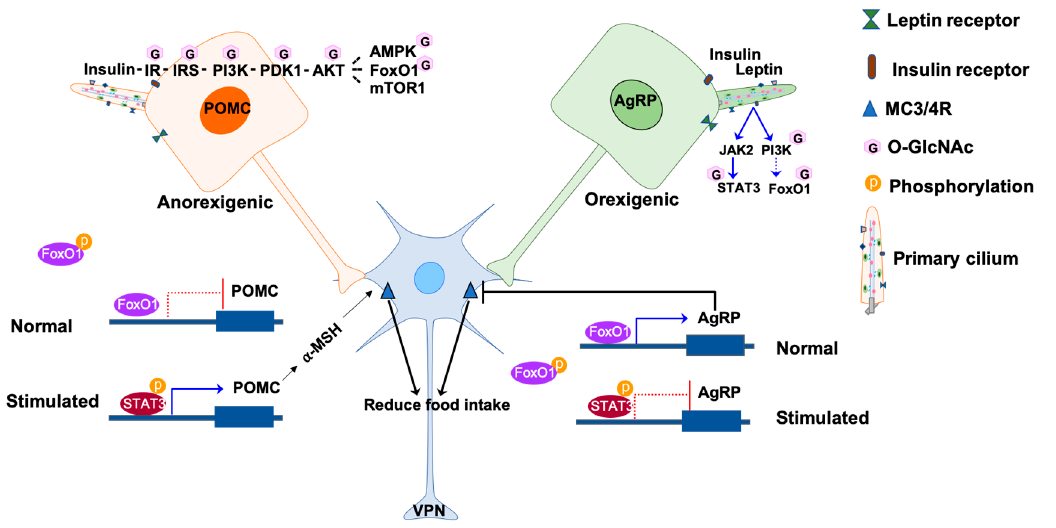
Figure 1. Involvement of O-GlcNAc in primary cilia signaling in the hypothalamic neurons. The activities of POMC and AgRP neurons are regulated by insulin and leptin hormones in response to nutrients. Under normal conditions, FoxO1 binds to the promoters agrp and pomc but have di ff erent e ff ects. FoxO1 promotes the expression of AgRP to inhibit the activation of lateral neurons in the VPN through MC3 / 4R, while FoxO1 inhibits the expression of POMC. The binding of insulin or leptin to the receptors on the neuronal membrane phosphorylates and activates a downstream signal, such as JAK2-STAT3 and PI3K-PDK1-AKT-FoxO1. The phosphorylated FoxO1 is excluded from the nucleus, enabling the binding of phosphorylated STAT3 to the promoters. The binding of pSTAT3 to the agrp promoter inhibits AgRP expression thus releasing the inhibition to the lateral neurons. On the other hand, the binding of pSTAT3 to the pomc promoter promotes POMC expression and activate the lateral neurons to reduce hunger. The O-GlcNAcylated molecules are labeled with pink hexagons. The phosphorylated molecules are labeled with orange circles. IR, insulin receptors; IRS, insulin receptor substrate proteins; PI3K, phosphatidylinositol-3-kinase; PDK1, 3-phosphoinositide-dependent protein kinase 1; AKT, protein kinase B; AMPK, AMP-dependent kinase; FoxO1, forkhead box protein O1; mTOR1, mammalian target of rapamycin 1; JAK2, Janus kinase 2; STAT3, signal transducer and activator of transcription 3; MC3 / 4R, melanocortin 3 and 4 receptors; AgRP, agouti-related peptide; POMC, proopiomelanocortin.